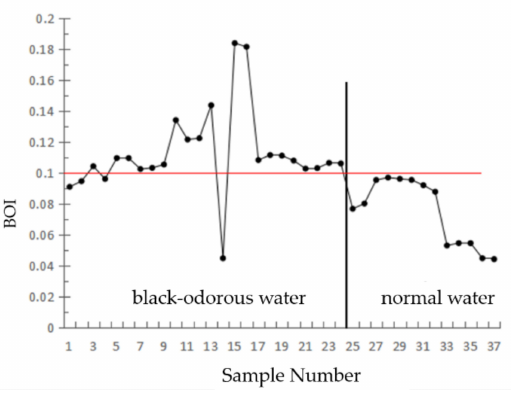
Figure 8. Normalized black-odorous water index after